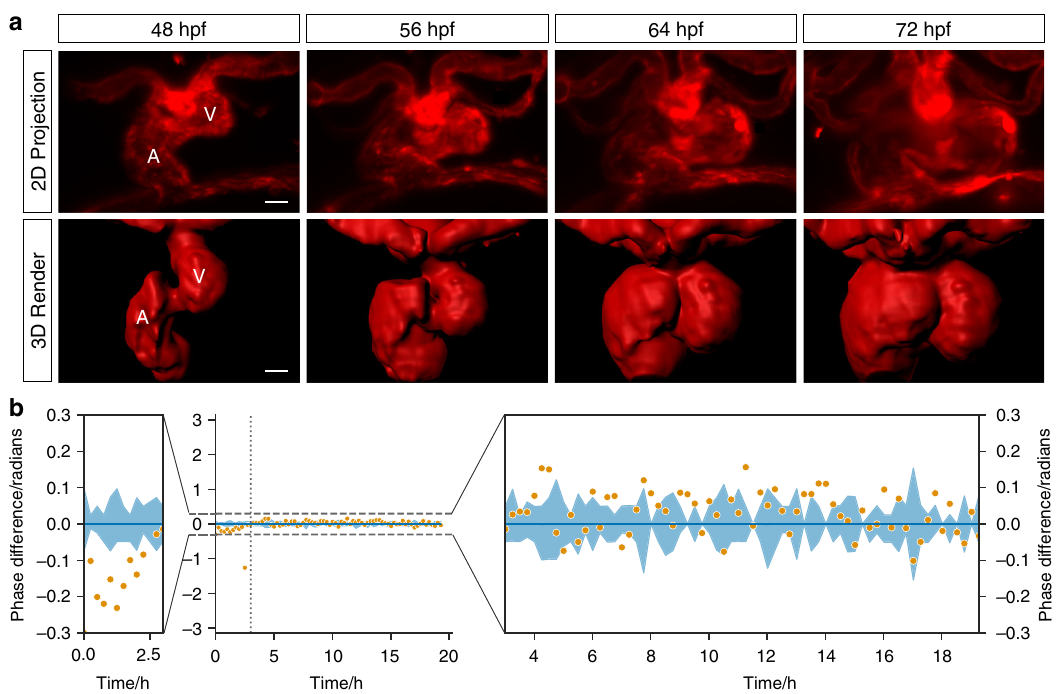
Fig. 3 Phase-locked, day-long cardiac time-lapse imaging of cardiac morphogenesis. a The process of cardiac looping, previously observed by histological studies at signi fi cantly lower temporal resolution, is now seen in direct 3D video detail (48 – 72 hpf, at 300 s intervals). The endothelium lining blood vessels and heart chambers is seen during completion of cardiac looping (red — transgene fl k1 :mCherry). Selected timepoints shown as maximum intensity projections (MIPs) of z -stacks and 3D render (from Supplementary Videos 4 and 5). V ventricle; A atrium. b Adaptive prospective optical gating algorithm (orange) phase-lock performance is compared against human judgements of best-matching frames (blue; line represents mean and shaded area represents the standard deviation). Viewing over the full 2 π range (middle) con fi rms the high precision and accuracy of the gating. Zoomed details (left and right) reveal a minor residual drift in phase during the early time period in which the heart underwent the most dramatic changes in shape and position,